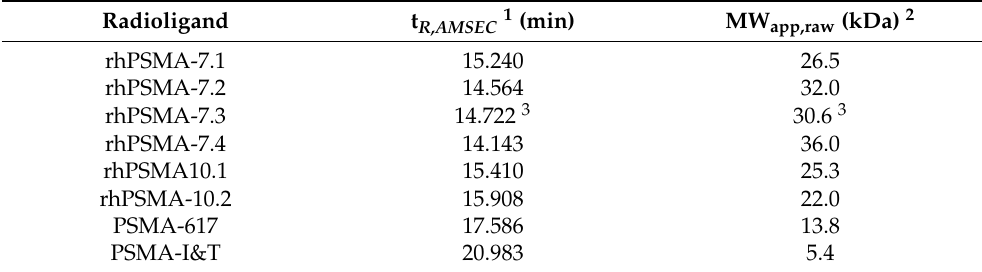
Table 1. Retention times of rhPSMA radioligands, PSMA-617, and PSMA-I&T in AMSEC runs (t R,AMSEC ) and corresponding raw apparent molecular weights (MW app,raw ). Radioligand t R,AMSEC 1